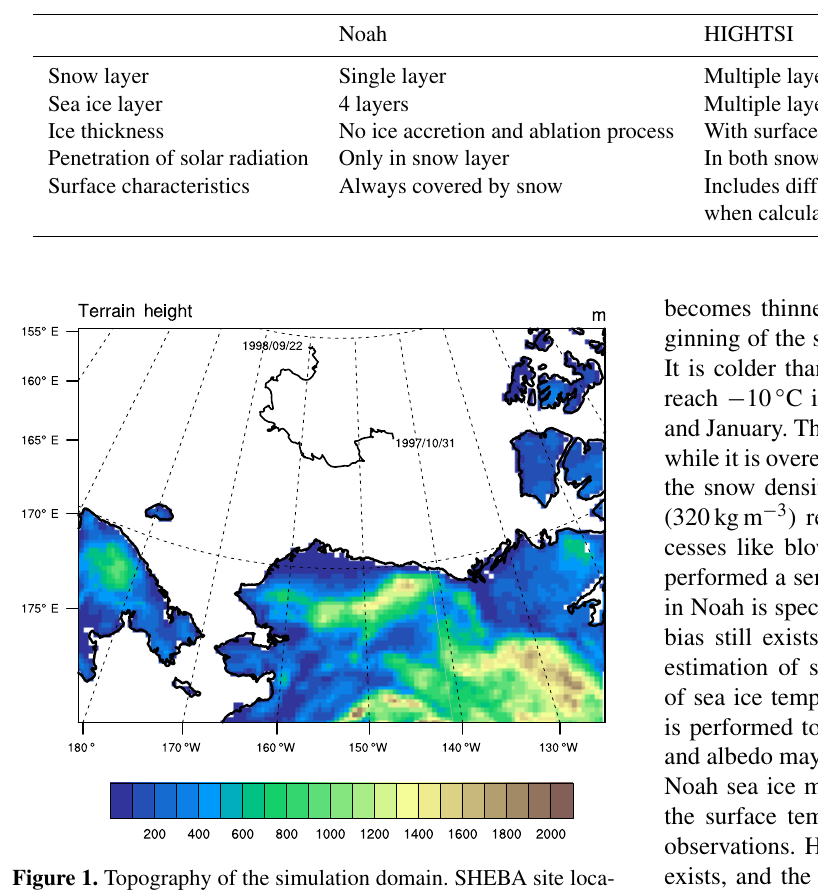
Table 1. Summary of the major differences between Noah and HIGHTSI